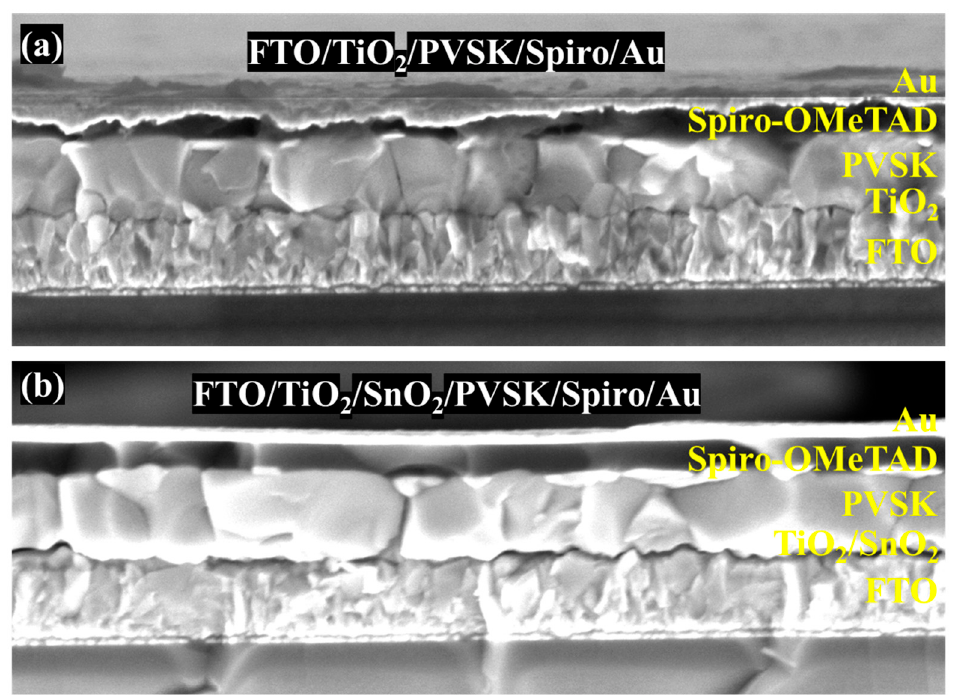
Figure 4. Cross-section images of PSCs in ( a ) TiO 2 - PSCs and ( b ) TiO 2 /SnO 2 PSCs.